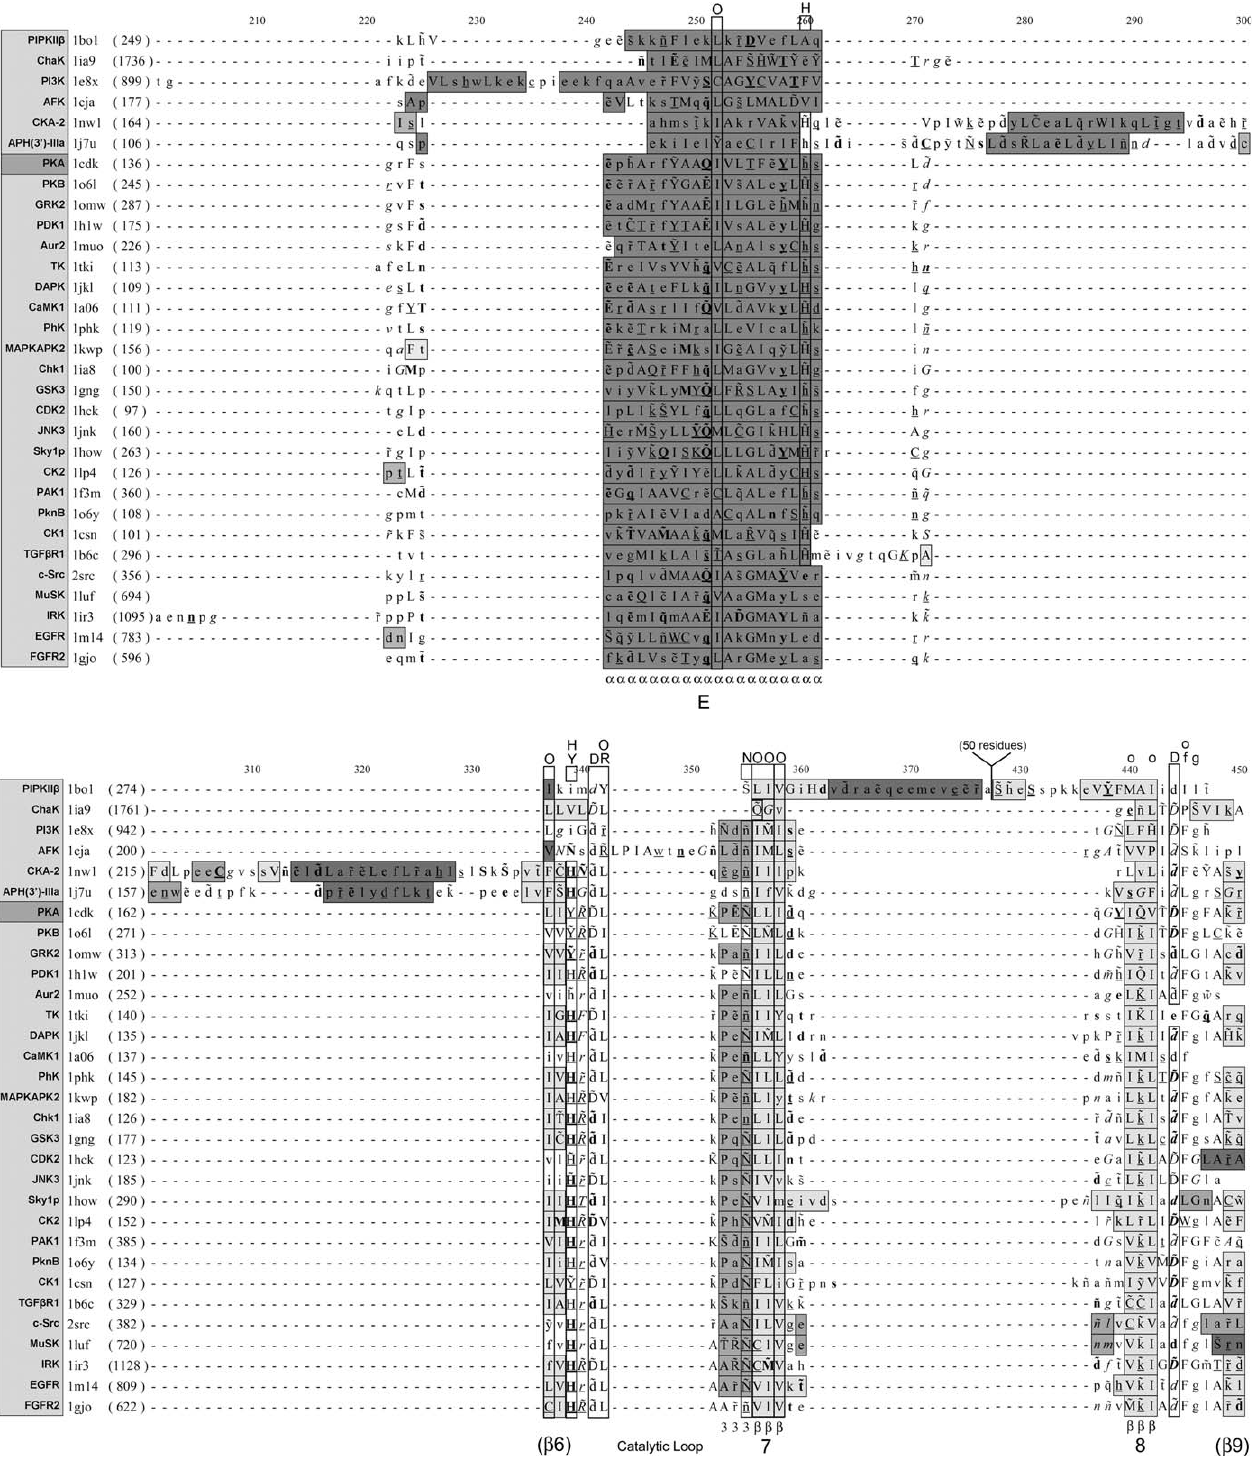
these positions are shown in uppercase above the boxes. The letter O stands for general hydrophobicity, but not a specific residue type. Residues that are more weakly conserved in the TPKs but are also conserved in many other AK families are noted with a lowercase letter above the appropriate alignment columns. Selected residues of interest that are conserved only within the TPKs are depicted using the same conventions above, but with gray lettering (depiction of residues conserved only in the TPKs is not exhaustive, i.e., only residues discussed in the text are highlighted above the alignment. Generally, this is done in structural regions unique to the TPKs). Secondary structures are labeled with the nomenclature used for PKA [12]. Sequence representing unresolved portions of the structure is not shown by JOY. In key portions of the alignment, this sequence is added back in and shown in light gray. DOI: